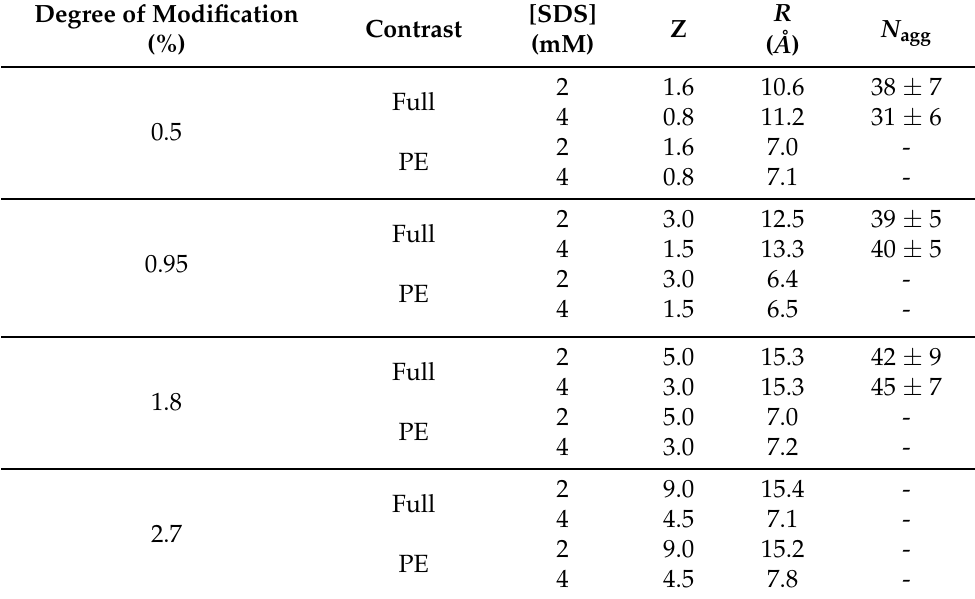
Table 3. Fitted structural parameters for binary mixtures containing 1 wt% cat-HEC polymers with different degrees of charge modification and h-SDS (full contrast) or d-SDS (PE contrast). Z is charge ratio, R is radius, and N agg is surfactant aggregation number calculated using Equation (5). The fitted fractal dimension ( f ) is 3.0 ± 0.2 for all